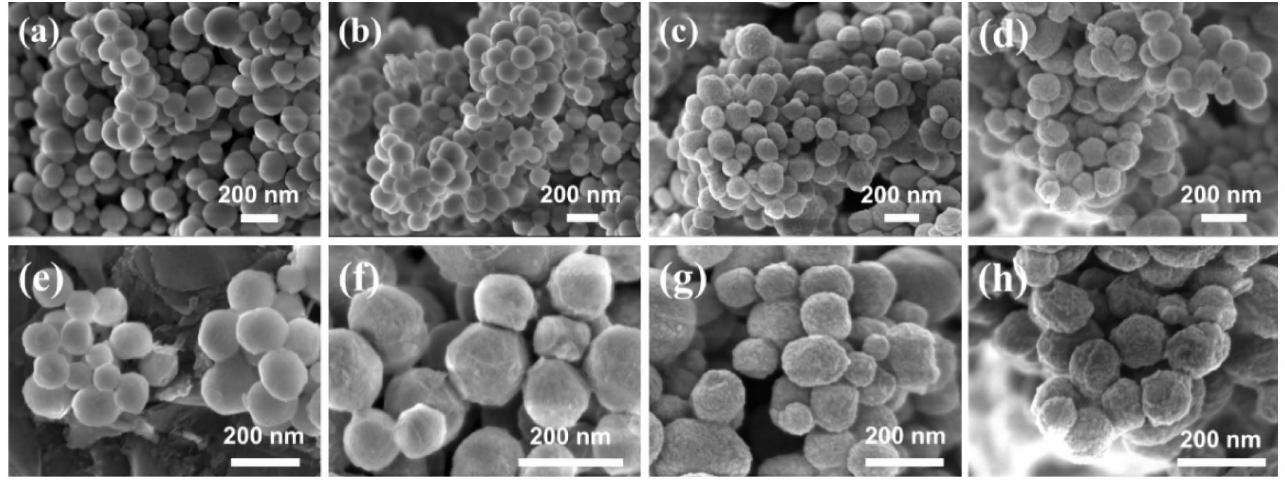
Figure 1. SEM images of ( a , b ) MCM-41, ( c , d ) MCM-41-TMSPM, ( e , f ) MCM-41-PAA, ( g , h ) Ca@MCM-